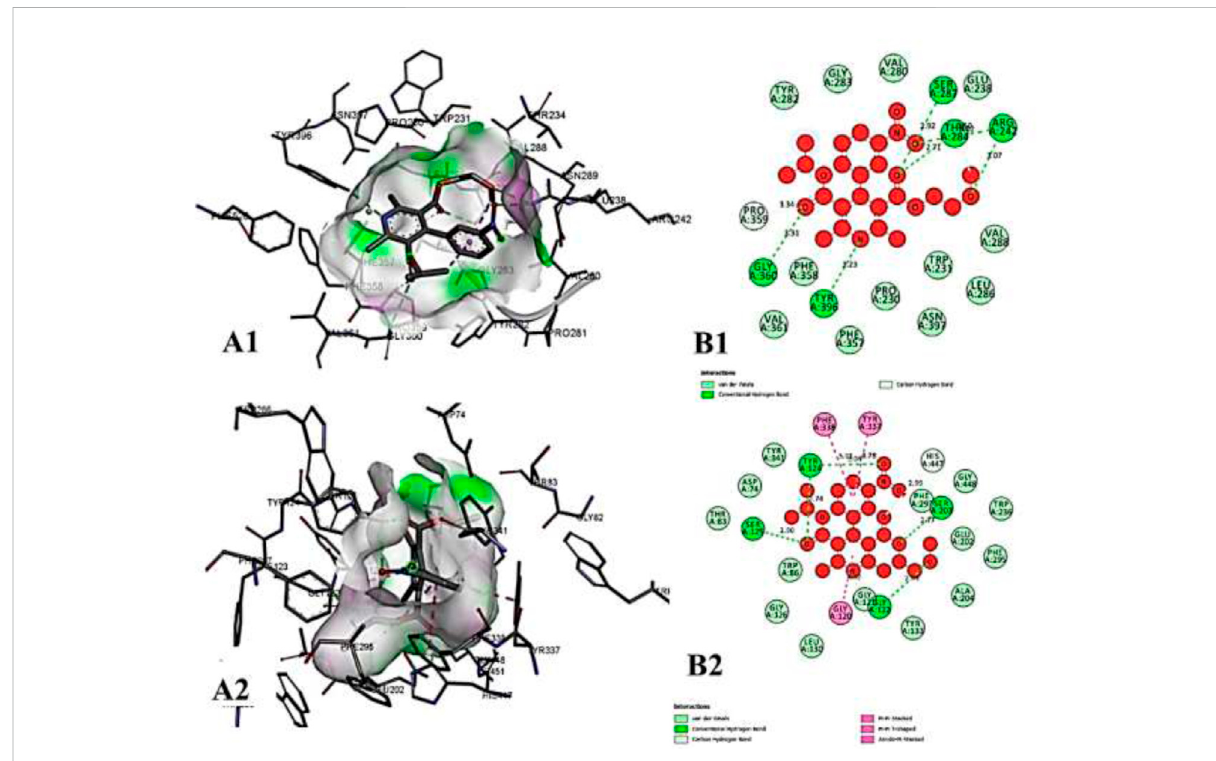
FIGURE 11 The molecular docking interactions of ligand N -acetylcilartatin with (A) 4AQD and (B) 4EY7 receptors in 2D and 3D